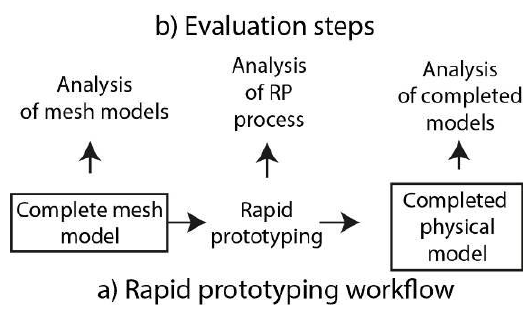
Figure 7. Workflow ( a ); and evaluation steps ( b